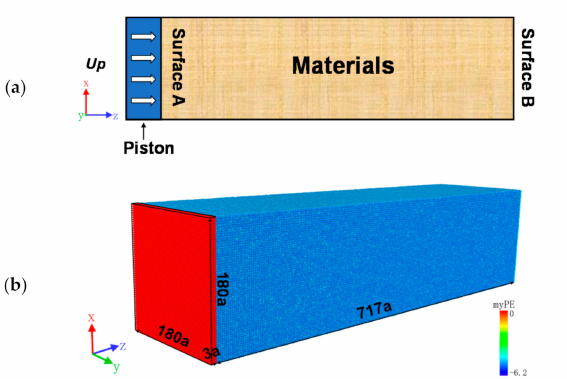
Figure 2. Multidimensional simulation model of piston impact load: ( a ) schematic diagram of piston impact method; ( b ) demonstration of molecular dynamics model in